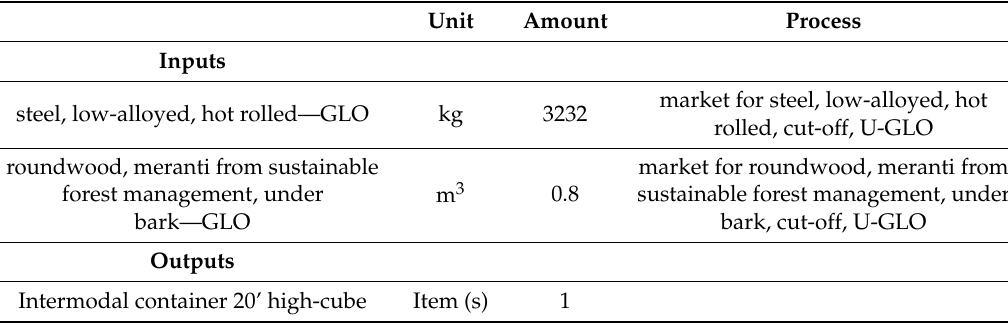
Table A8. Manufacturing, Intermodal container 20’ high cube.